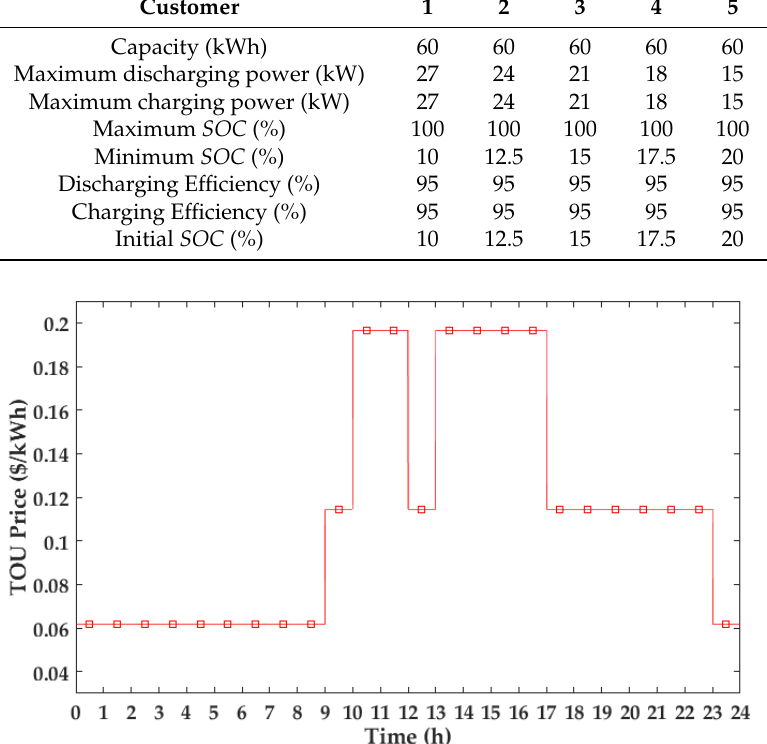
Table 1. Detailed specification of the ESS.